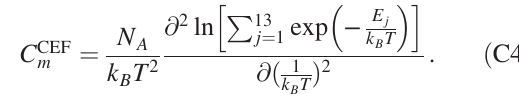
J , and J − ( J þ vectors of Eq. (C1) are given by E